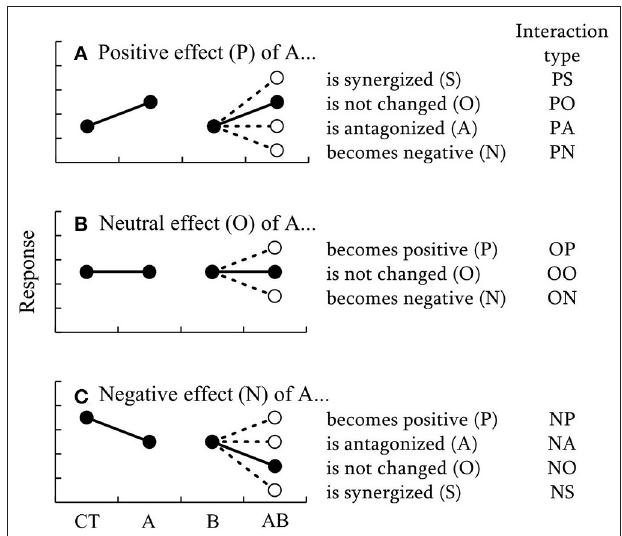
FIGURE 1 | Schematic diagrams of 11 types of interactions proposed as a new classification to describe how the effect of a certain factor, A, varies with some other factor, B. The changes of the (A) positive, (B) neutral, (C) negative effects of A by B are shown separately. CT, A, and B indicate control, and treatments with elevated level of factors A and B, respectively. Black and white circles indicate the results of additive and non-additive effects, respectively.